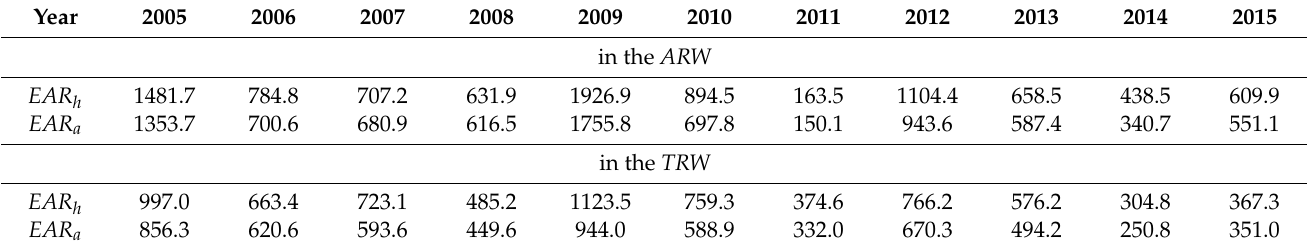
Table 2. The statistical data of the EAR values from 2005 to 2015 in the two watersheds.